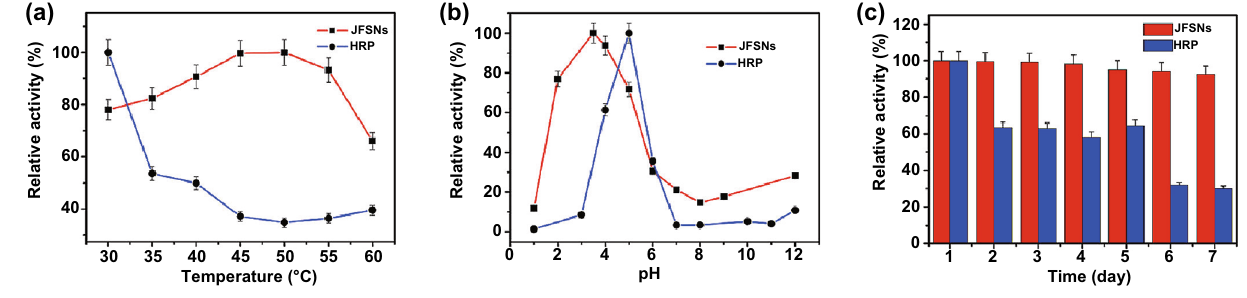
Fig. 3 a – c pH-, temperature-, and time-dependent POD activities of the nanozyme JFSNs and the natural enzyme HRP. Reproduced with per- mission from Ref. [41]. Copyright 2015, American Chemical Society